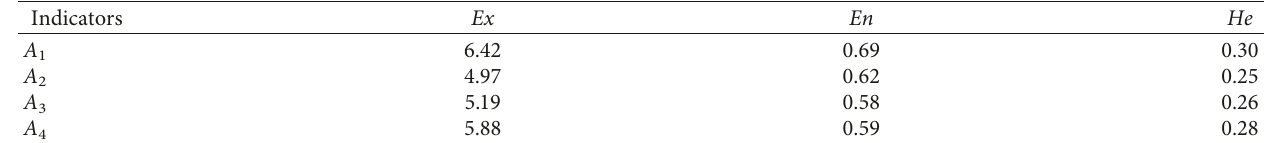
Table 6: First-level indicators of section ZK70+875 ∼ ZK71 +005.